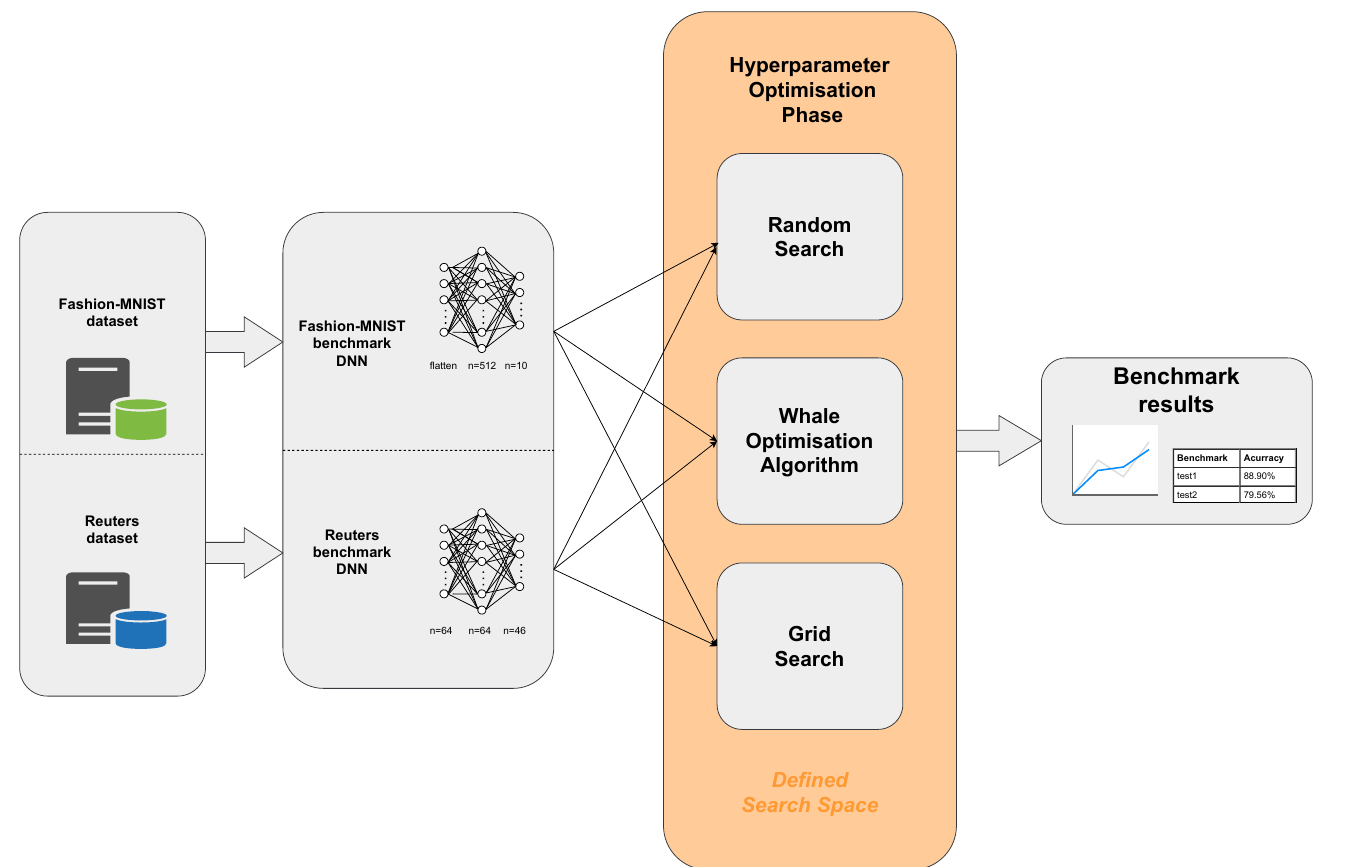
Figure 3. Benchmark diagram for deep neural network hyperparameter